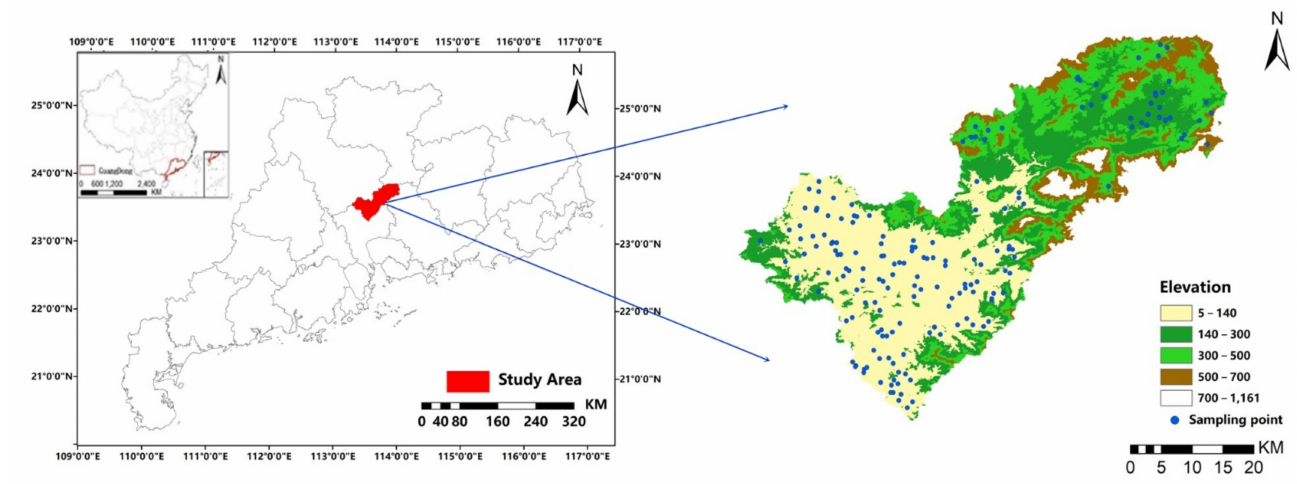
Figure 1. Location of the study area and sampling point